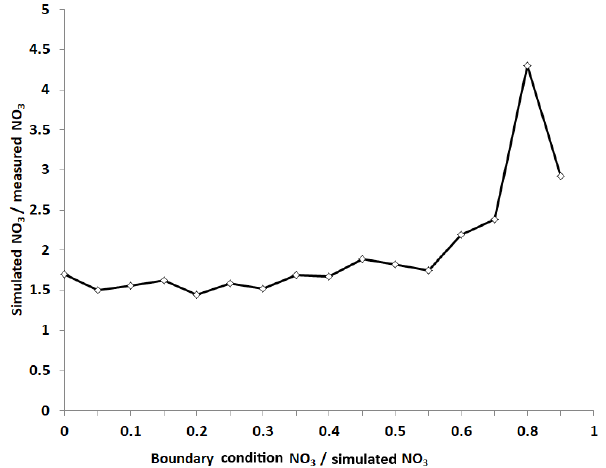
Figure 12. Ratio of simulated vs. measured particulate nitrate (PNO 3 ) concentrations against the boundary contributions to simu- lated PNO 3 at IMPROVE sites over a 12km